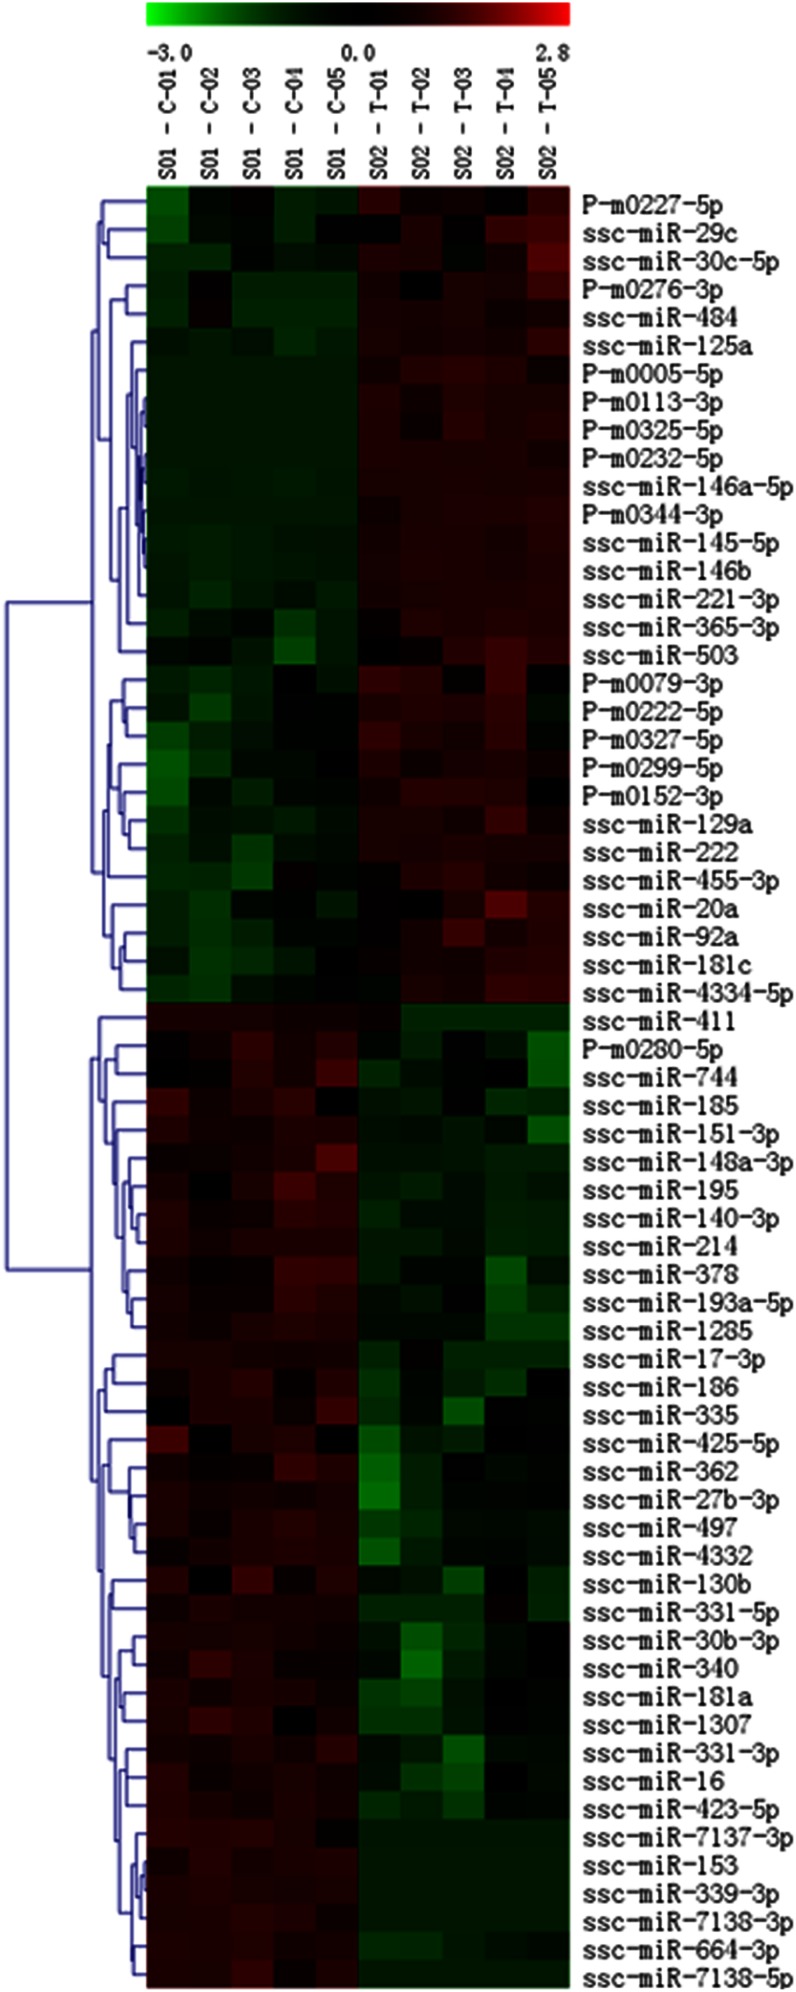
Heat map of miRNAs differentially expressed after TNF-α treatment. S01-C01-05 represents the control group, while S02-T01-05 represents the TNF-α group. Red denotes upregulated miRNAs, and green denotes downregulated miRNAs.